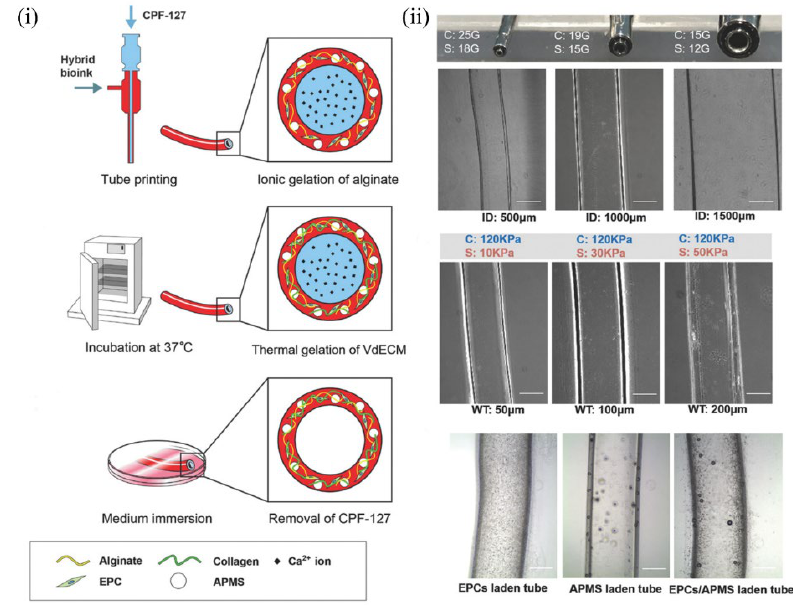
Figure 9. Schematic of research strategy: ( i ) schematic diagram of manufacturing coaxial vascular device and materials; and ( ii ) schematic diagram of the coaxial blood vessel [146].